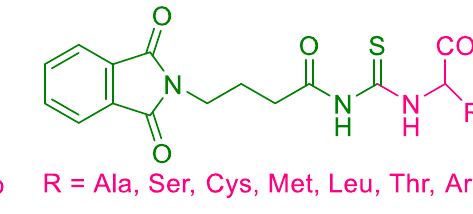
52 of 90 Figure 65. Coumarin/quinolinone conjugated to N-protected amino acids. Al-Masoudi N A et al. synthesised a series of N - α -amino acid derivatives conjugated to phthalimide moieties with the aim to develop new non-nucleoside reverse transcriptase inhibitors (NNTRIs) (Figure 66). From the previous literature, the authors found that the carbon-spacer length is crucial in the synthesis of potent anti-HIV agents. Hence, in this work, they selected phthalimido-(substituted-alkyl-2-thioureido) alkyl carboxylic acid containing three carbon atoms spacer. The conjugates, methyl 2-(4-(phthalimido-2-yl)bu- tanamido) alkyl carboxylates ( 81 ), were synthesised by the acylation of phthalimide acid followed by treatment with ammonium thiocyanate to obtain isocyanate intermediates, which were coupled with various amino acids (Ala, Ser, Cys, Met, Leu, Thr, His, Arg and Tyr). Conjugates containing phthalimido-(substituted-alkyl-2-thioureido) alkyl carbox- ylic acid derivatives ( 82 ) were synthesised starting from NH 2 -AA-OMe (AA = Ala, Val, Ser, Cys, Met, Leu, Thr, Phe, Trp and Pro). The newly synthesised conjugates were tested for antiviral activity against HIV-1 and HIV-2 strains in MT-4 cells. The compounds con- taining heterocyclic structures, such as Trp and methyl proline moieties, exhibited inhibi- tion of HIV-replication at EC 50 lower than the CC 50 compared to the standard nevirapine and azidothymidine. The most active conjugates showed an effective 50% decrease in the cytopathogenicity induced by HIV-1 at CC 50 of 29.61 and 101.90 μM and EC 50 > 4.23 and 20.38 μM, resulting in a selective index of 5 and 7, respectively, at non-toxic concentration. Conjugates were subjected to docking study using HIV-1 reverse transcriptase enzyme (Autodock Tools) to study the interactions and binding energy. One of the active com-